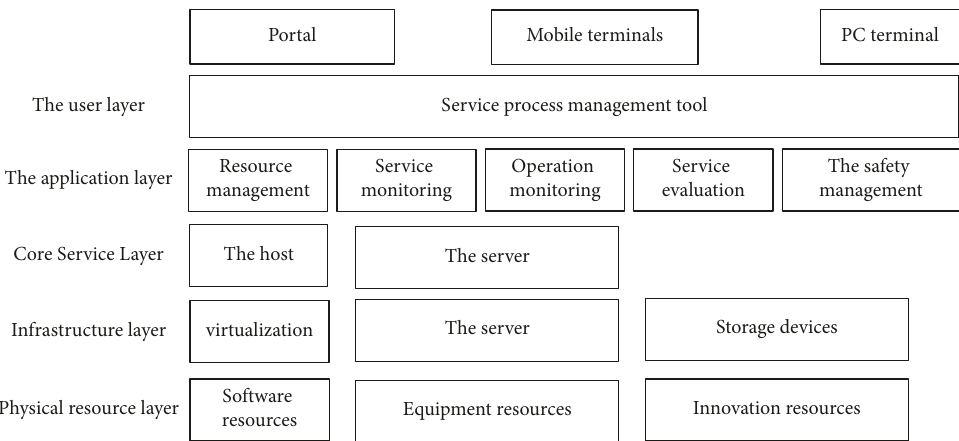
Figure 3: 3D printing platform system of ceramic